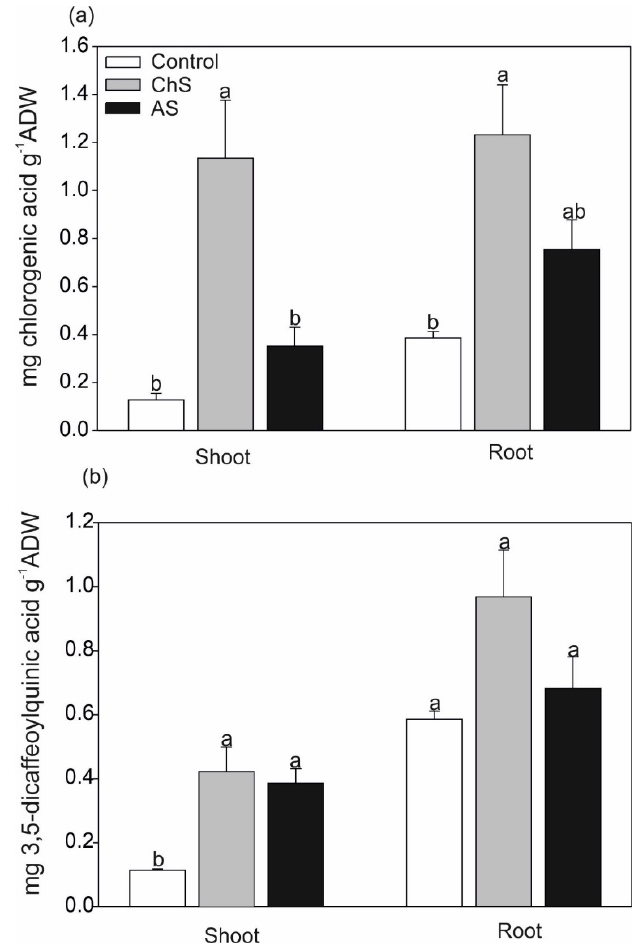
Figure 6. Effect of long-term chronic cadmium stress (ChS, 0.1 µM Cd, 85 days) or short-term acute cadmium stress (AS, 10 µM Cd, 4 days) on ( a ) chlorogenic acid and ( b ) 3,5-dicaffeoylquinic acid in the shoots and roots of C. acaulis . Data are means ± SE ( n = 5); values followed by the same letter are not significantly different ( p < 0.05, Tukey’s test).